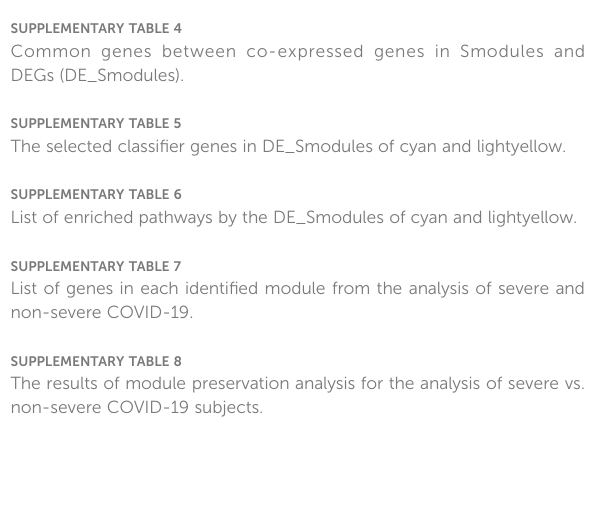
SUPPLEMENTARY TABLE 4 Common genes between co-expressed genes in Smodules and DEGs (DE_Smodules).